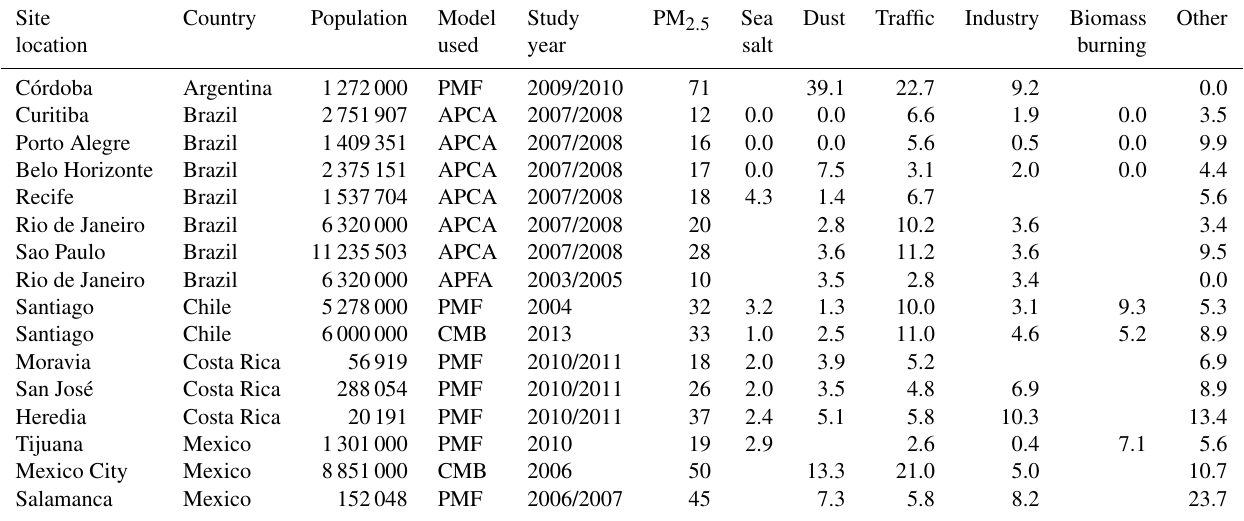
Table 1. Comparison of source-apportionment studies in Latin American cities (WHO, 2017). Total PM 2 . 5 and its sources are expressed in micrograms per cubic meter (µgm − 3 ).